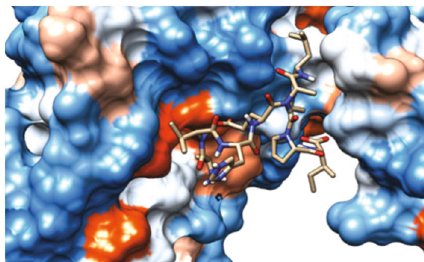
Figure 11: Illustration of the 3D interaction of the best docking poses of AVHEALAPI in the binding sites of HLA-A ∗ 02:06.